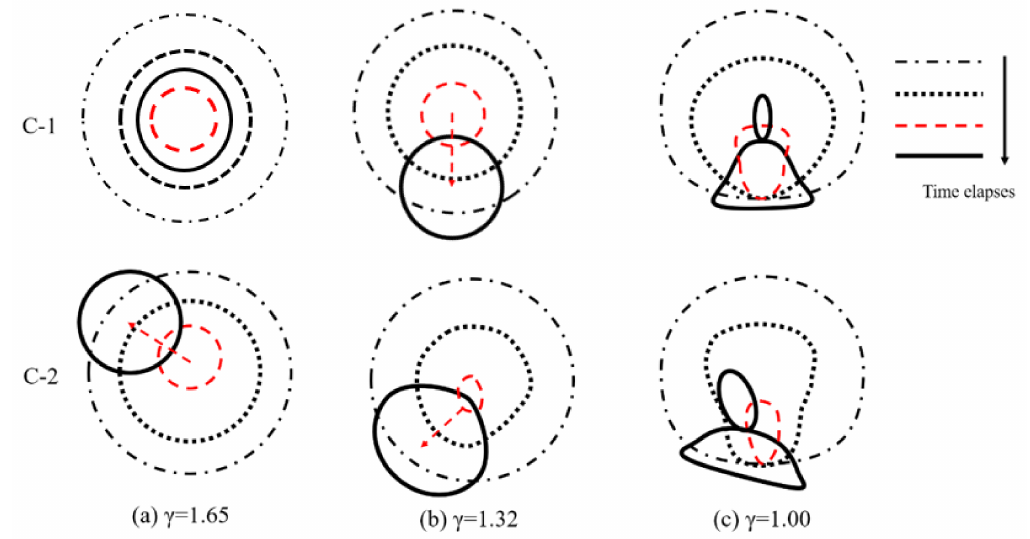
Figure 6. Comparison of bubble collapse patterns in side view near C-1 and C-2 plates under different initial distances ( a ) γ =1.65, ( b ) γ =1.32, ( c ) γ